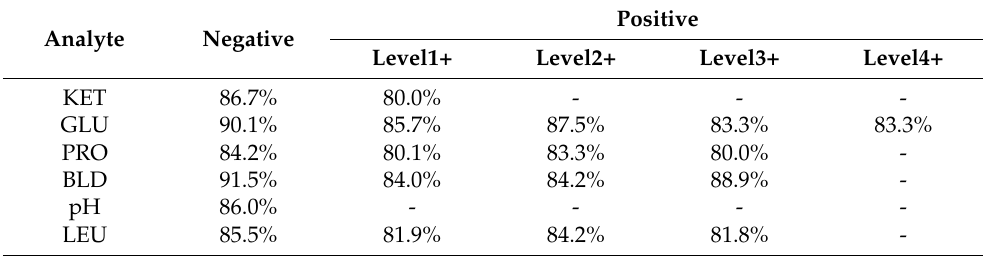
Table 2. Comparison of the detection results generated by the proposed colorimetric urinalysis and a hospital instrument.